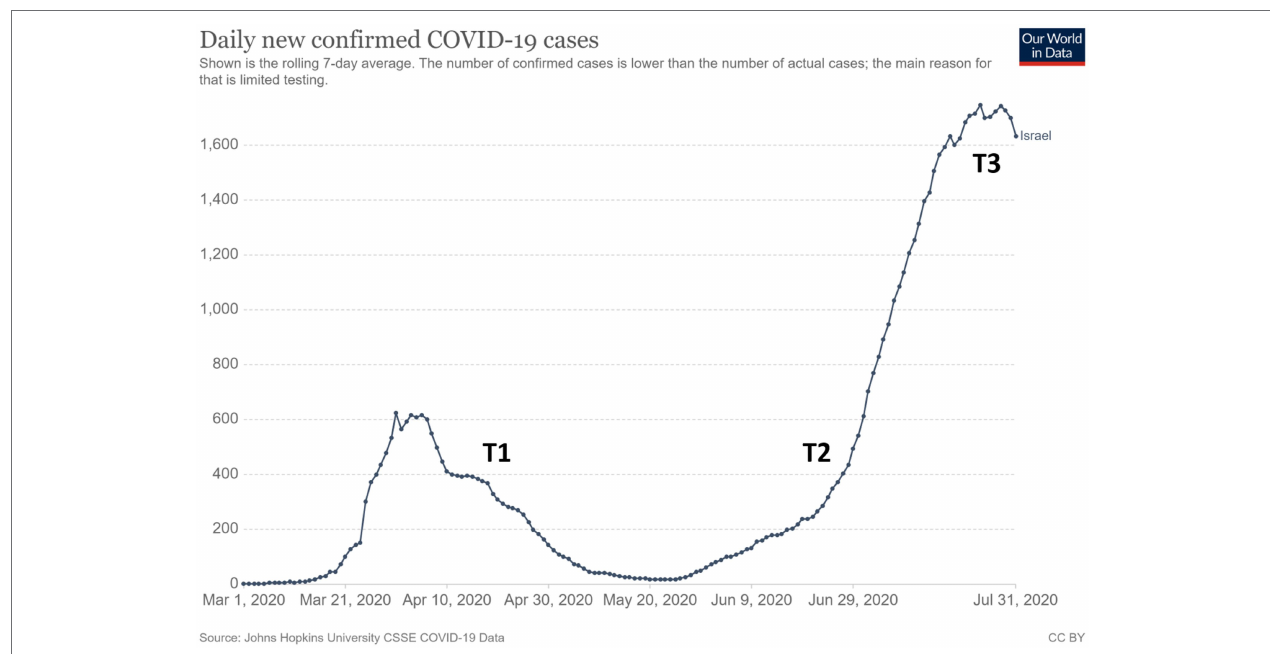
FIGURE 1 | Daily changes in confirmed COVID-19 cases during the time of the study (extracted from Ritchie et al., 2020). The study’s three time points are marked along the